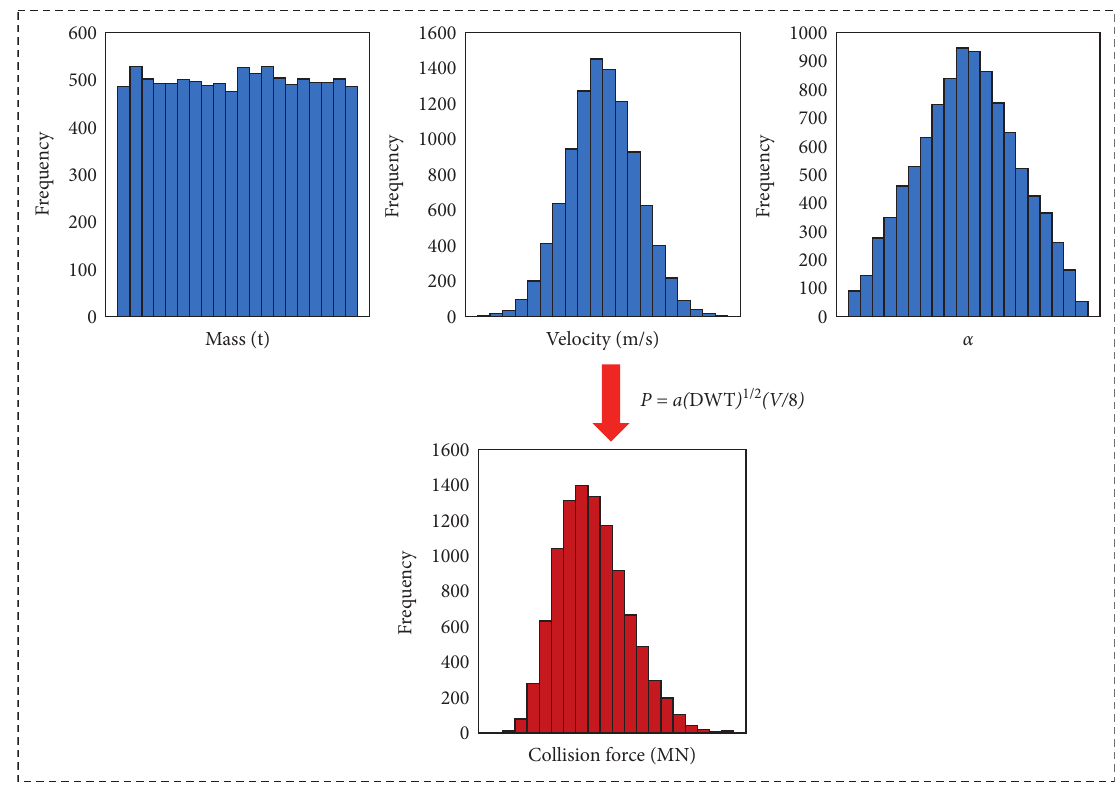
Figure 7: Evolution of probabilistic distribution of ship impact force based on Monte Carlo simulation.